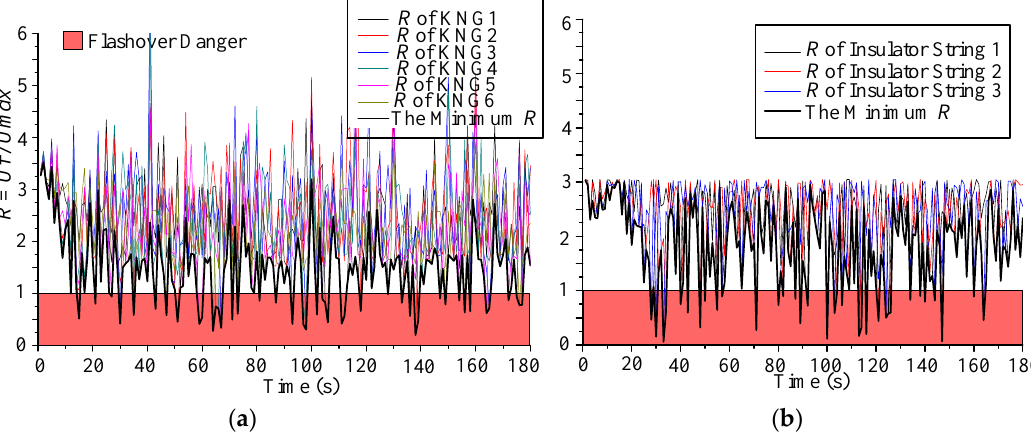
Figure 12. Safety factor, R , of windage yaw flashover. ( a ) Conductors / ground wires. ( b ) Insulator string.